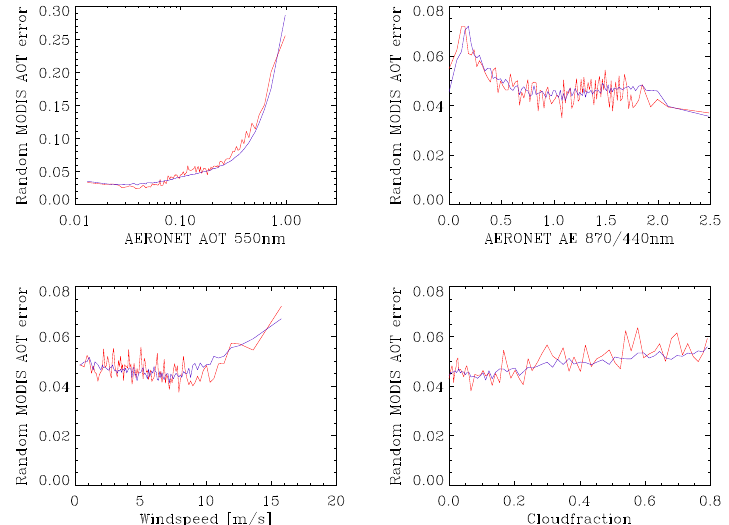
Fig. 18. Random Aqua AOT errors in the corrected observations. In red, the error estimated from binned observations, in blue our error model.